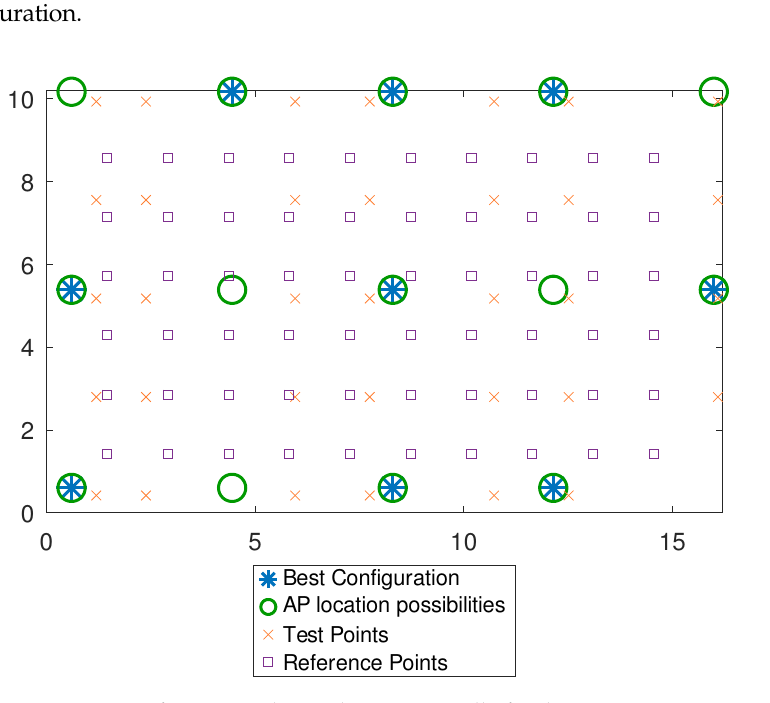
Figure 14. Best AP configuration obtained experimentally for the Geotec scenario considering 9 APs, 60 RPs and 5 samples collected per